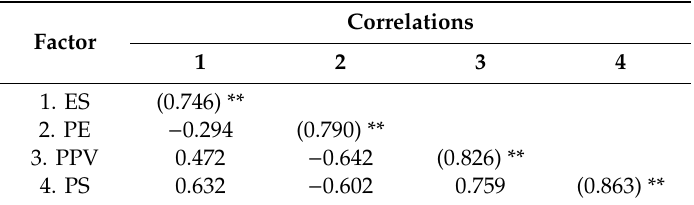
Table 4. Descriptive statistics and